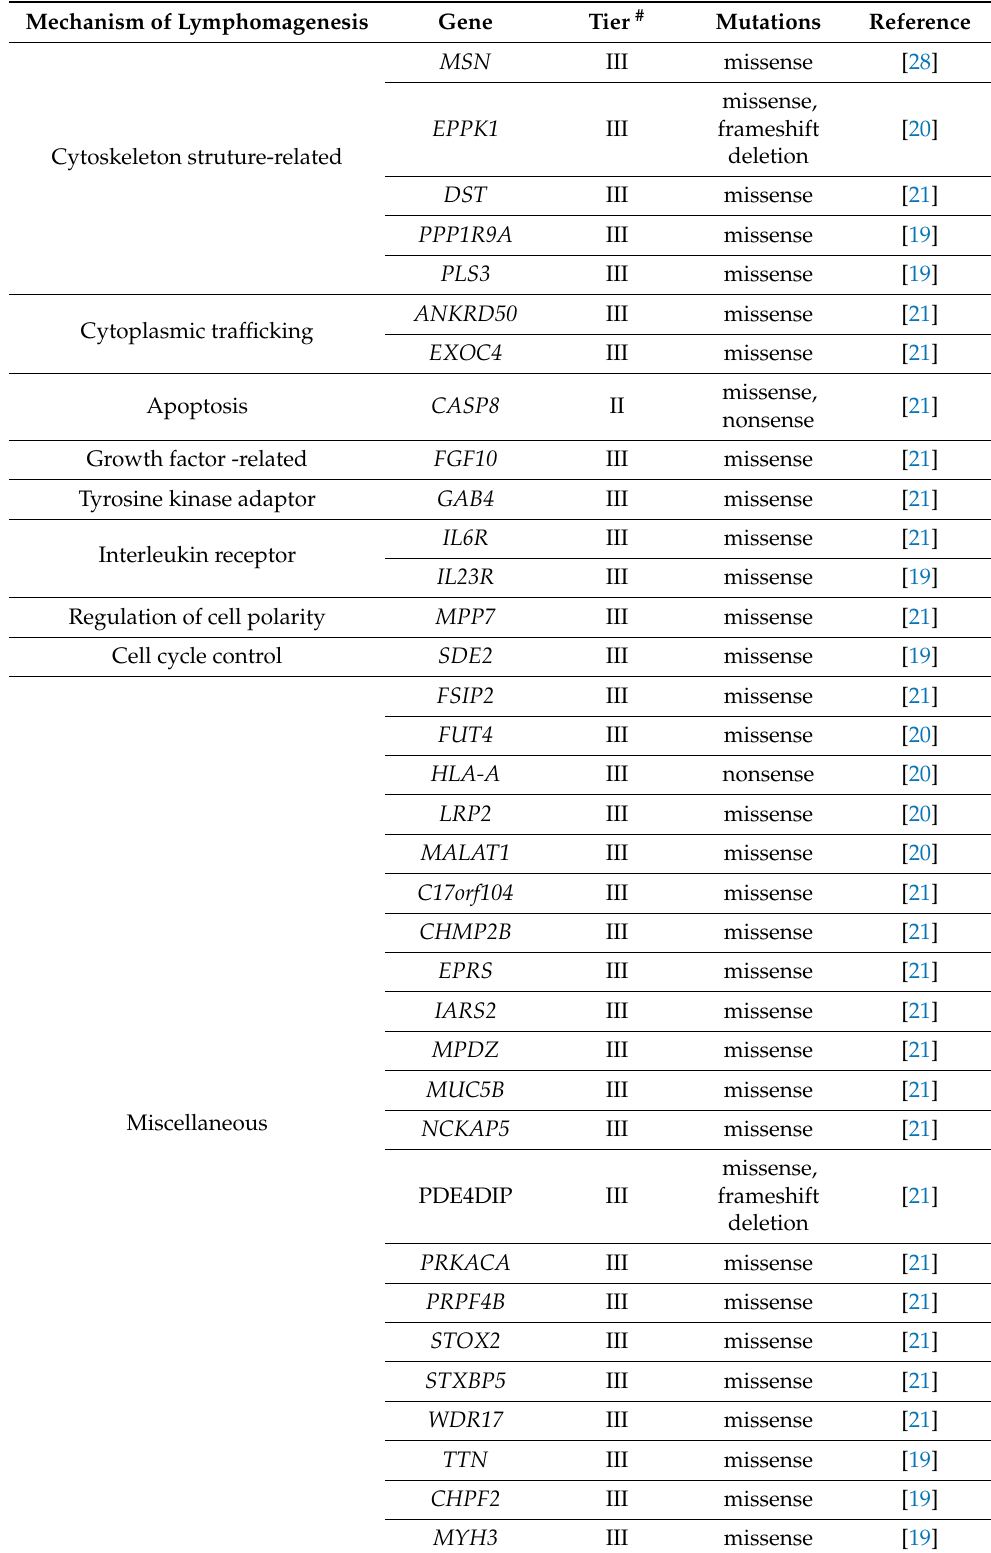
Table 1. Cont. Mechanism of